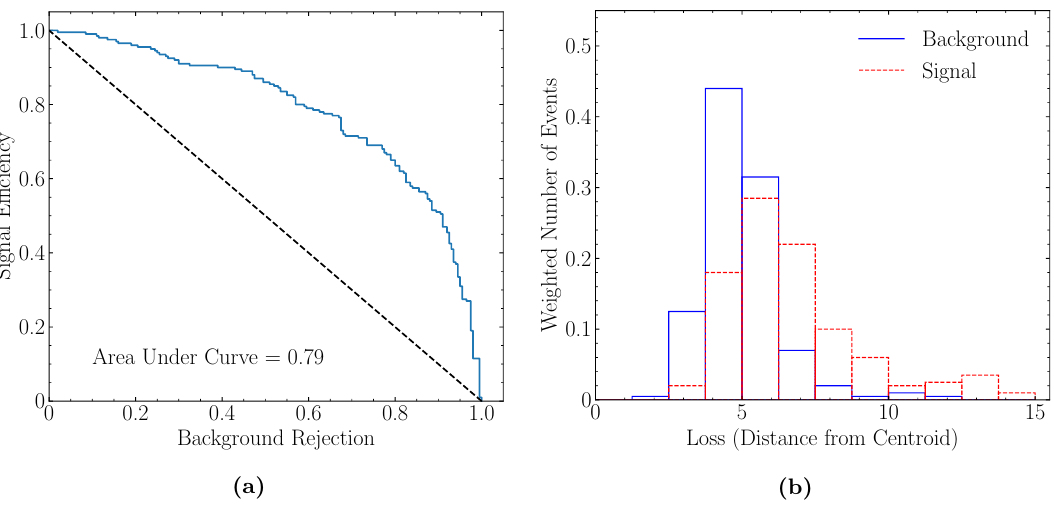
Figure 6. (a) shows the ROC curve for K-means anomaly detection method trained on feature vectors constructed from GBS samples. The distribution of the loss for the signal and background test sets is shown in